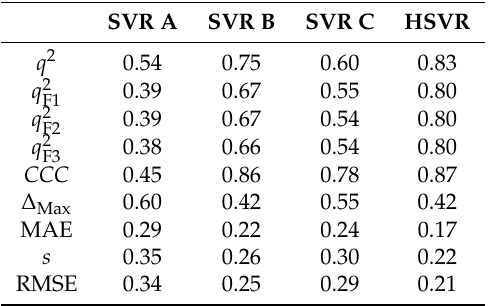
, q 2 , and q 2 , concordance correlation F2 F3 F1